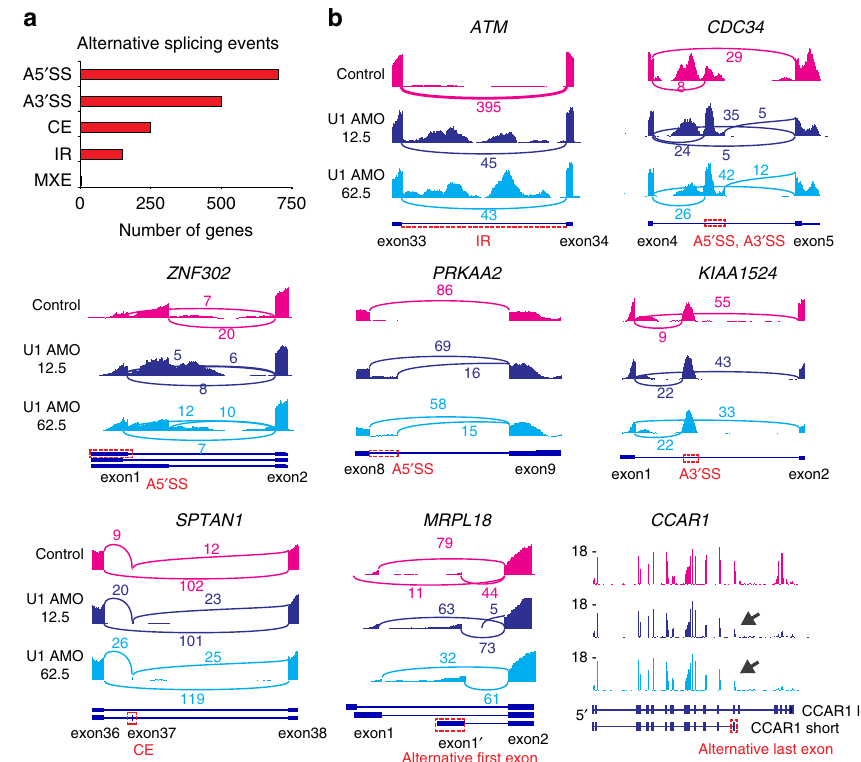
Fig. 4 Low U1 AMO causes widespread alternative splicing changes in HeLa cells. a Summary of alternative splicing events as identi fi ed with JUM analysis. Each alternative splicing event happened in both low U1 AMO 12.5 and 62.5 pmole in HeLa cells. (A5 ’ SS: alternative 5 ʹ splice site; A3 ’ SS: alternative 3 ʹ splice site; CE: cassette exon; IR: intron retention; MXE: mutually exclusive exons) b Sashimi plots and genome browser view of each alternative splicing change in the low U1 AMO 12.5 and 62.5